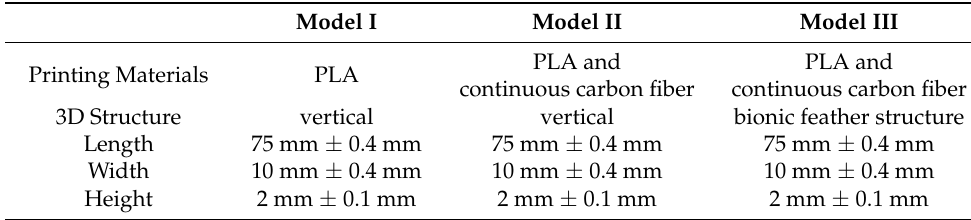
Table 1. Three types of print model parameters.